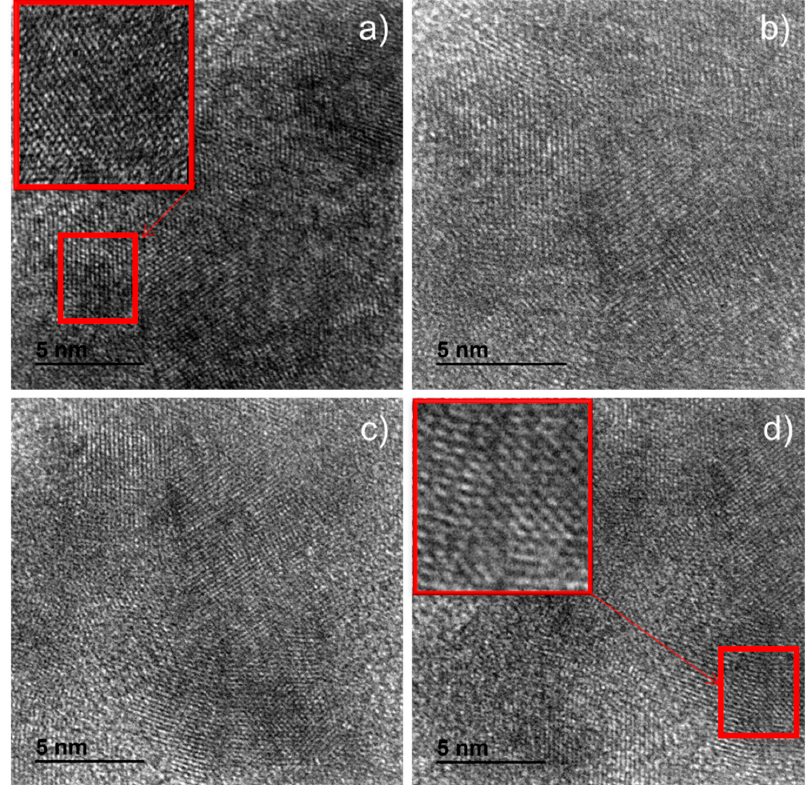
Figure 4. Set of TEM images taken for different four different parts ( a , b , c and d ) of (N)G pyrolyzed at 1200 °C under Ar/H 2 (5%). The hexagonal arrangement observed in the high-resolution images has been highlighted in red. The inset shows the Fourier-transformed electron diffraction pattern of image ( d ).